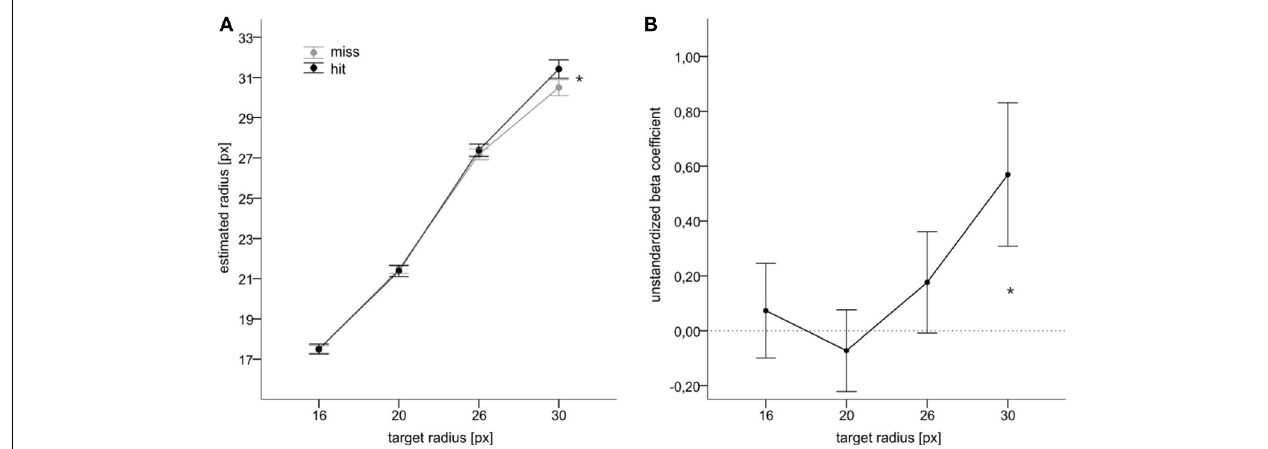
FIGURE 6 | Main results of Experiment 3. (A) Mean judgments of target radius as a function of target size and of action success. (B) Mean unstandardized beta coefficients for each target condition. Error bars reflect standard errors. Asterisks denote statistical significance ( p ≤ 0 . 05).